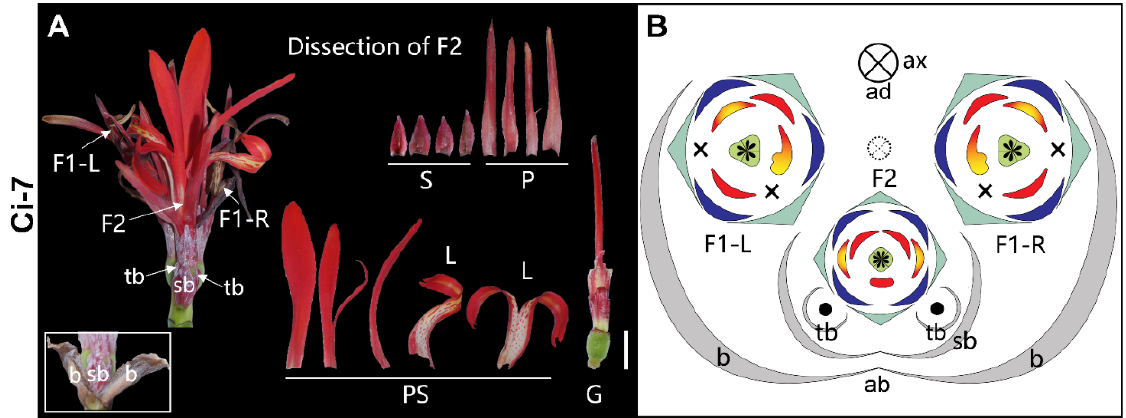
Figure 9. 2-flowered thyrse. ( A ) Photograph and ( B ) diagram of the partial inflorescence of Ci-6. Dashed line in (B) indicates the ovaries are fused. Bar = 1 cm.